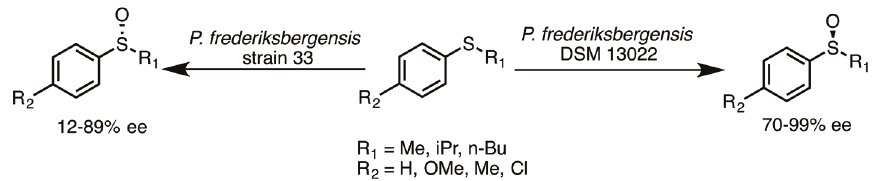
Figure 12 - Sulfide oxidation using P. frederiksbergensis